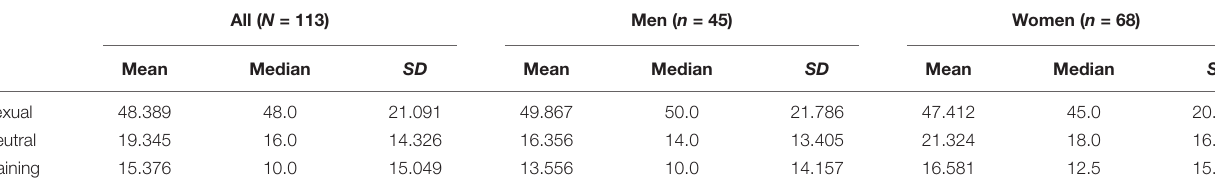
TABLE 3 | Picture recognition task: Mean accuracy scores (%), median, and SD .